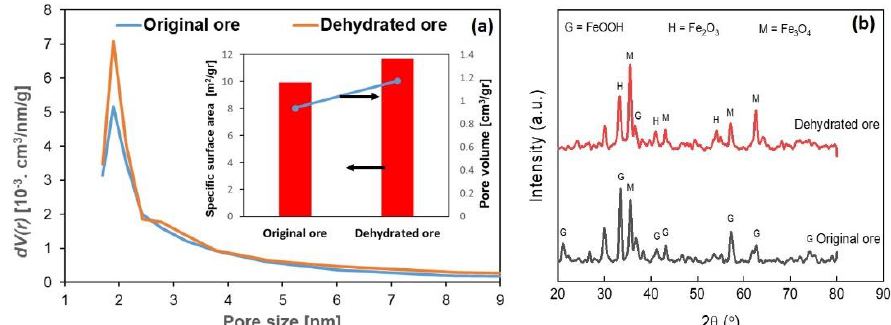
Figure 2. Alteration in ( a ) pore size distribution and S BET and V BJH values; ( b ) XRD patterns of original iron ore and dehydrated ore.